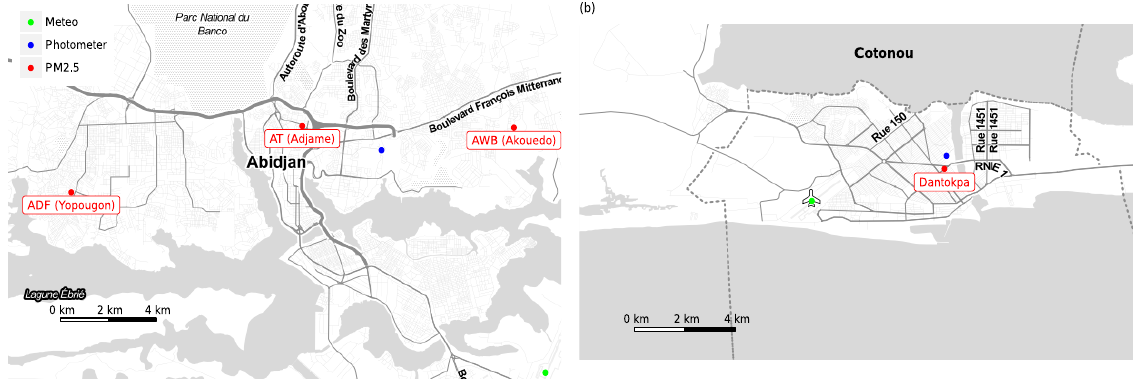
Figure 2. Maps of the cities of (a) Abidjan and (b) Cotonou reporting the location of the (red) PM 2 . 5 sampling sites, (blue) photometer measurements and (green) meteorological station.